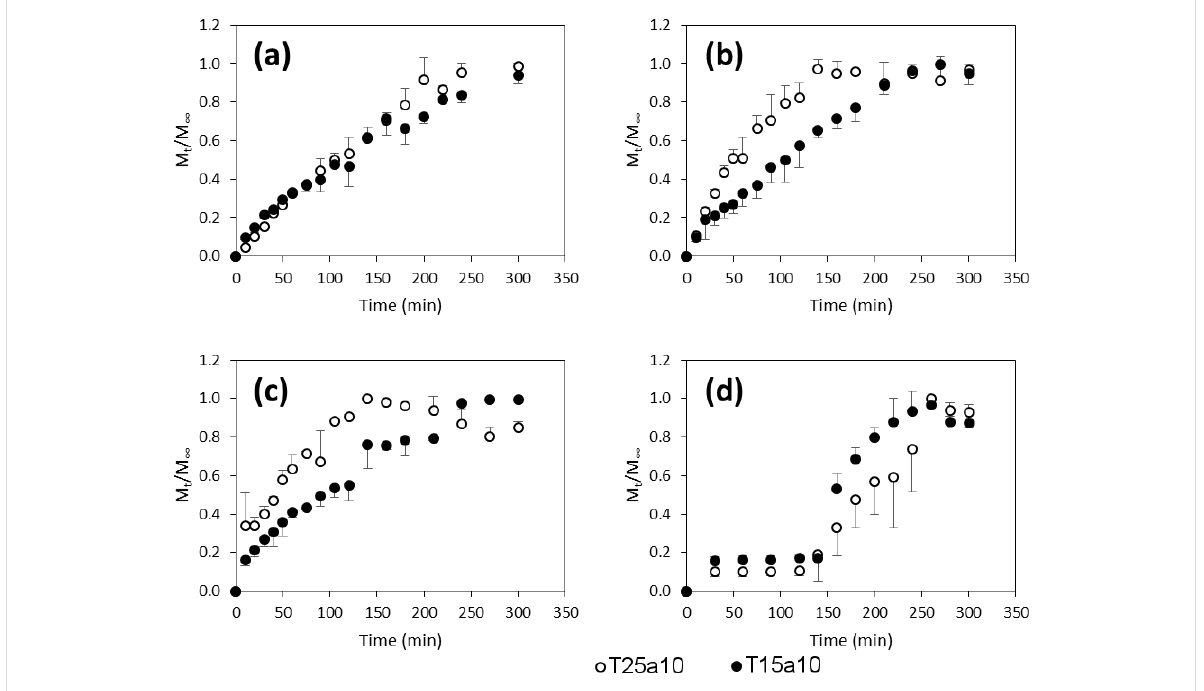
Figure 4: Release profiles of lactase from T25a10 (open circles) and T15a10 (filled circles) at pH 6 from a) gels with 29452 ALU, b) tablets with 4000–4500 ALU, c) tablets with 500–900 ALU and d) tablets with 4000–4500 ALU from pH 1.2 to pH 6 (d). ALU: acid lactase units.